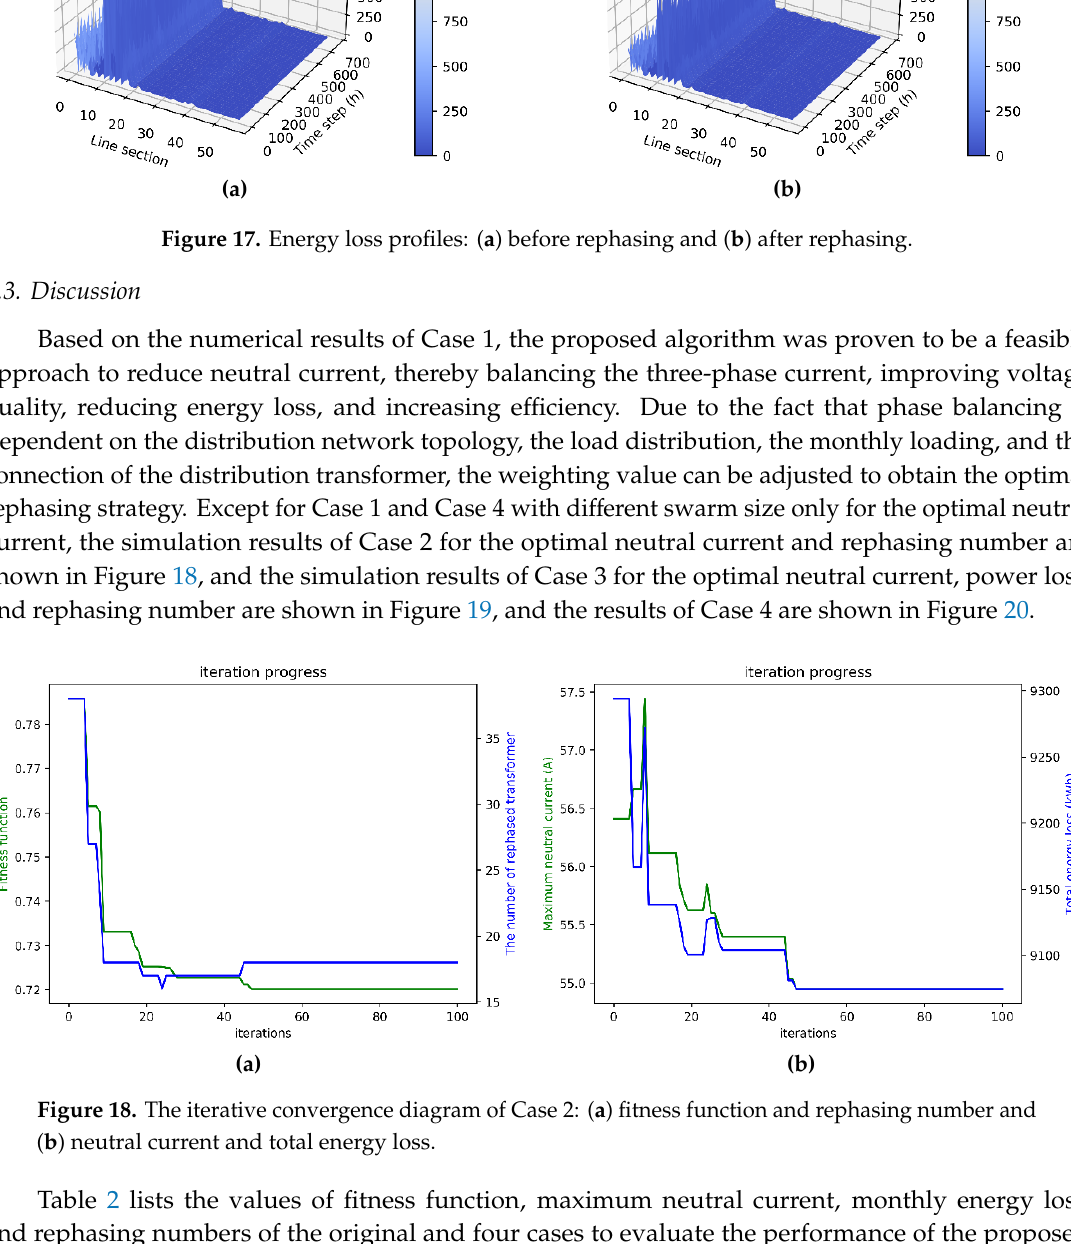
(b) Figure 19. The iterative convergence diagram of Case 3: ( a ) fitness function and rephasing number and ( b ) neutral current and total energy loss. (a) (b) Figure 20. The iterative convergence diagram of Case 4: ( a ) fitness function and rephasing number and ( b ) neutral current and total energy loss. 4. Conclusions In this paper, a monthly full-scale net load model derived from the FTU measurement data and predicted by LSTM was used to reduce the neutral current via phase arrangement optimization by PSO. The proposed multi-objective function, which is composed of neutral current, power loss, and rephasing number, was applied to solve the optimal phase arrangement problem of a practical